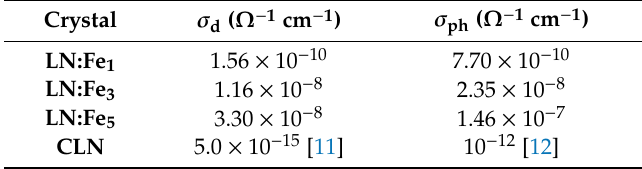
Table 1. The dark- and photo-conductivity of LN doped with 1.0, 3.0, and 5.0 wt.% Fe 2 O 3 . A 473 nm laser with light intensity of 1.8 W / cm 2 was applied to the measurement of photo-conductivity.